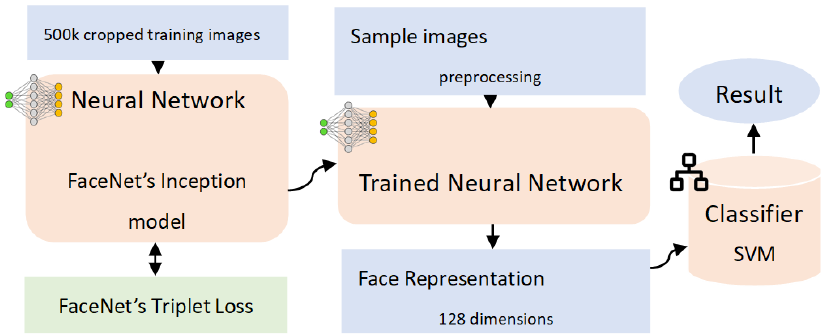
Figure 5. OpenFace nn4.small2 network structure.